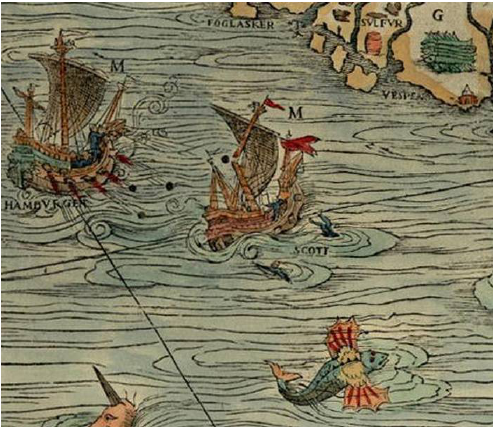
Figure 6. Carta Marina 1539 by Olao Magno (1490–1557), particular.